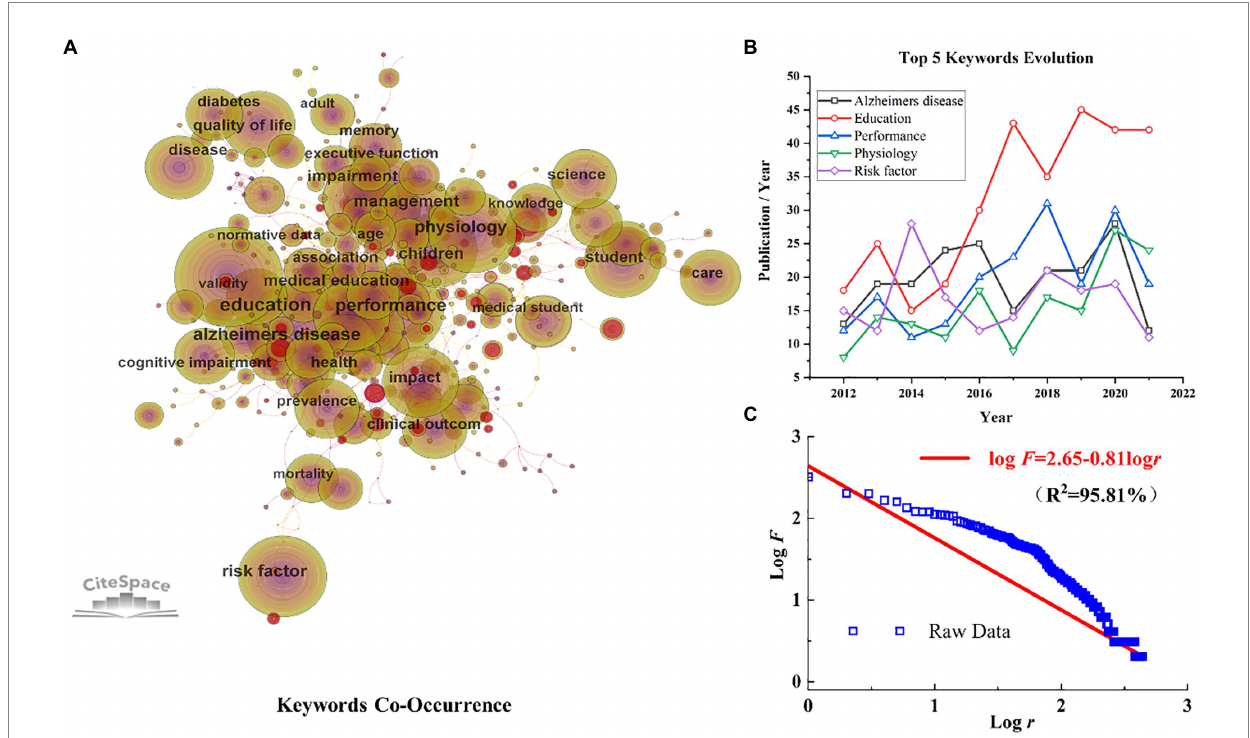
FIGURE 4 (A) The network of keywords co-occurrence. (B) The evolution of Top 5 keywords. (C) Zipf ’s law data fitting of key words in physiology teaching